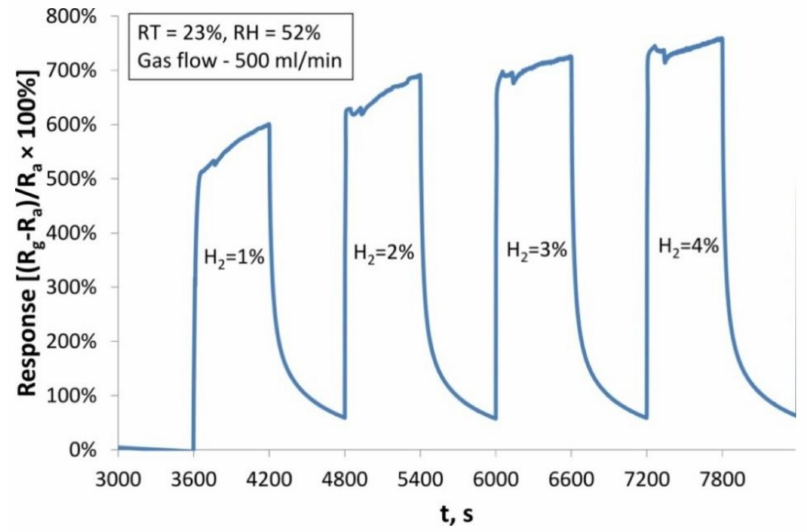
Figure A4. Response of ‘thicker’ PCz/IDE-Pt sensor to H 2 gas at RH = 52% at